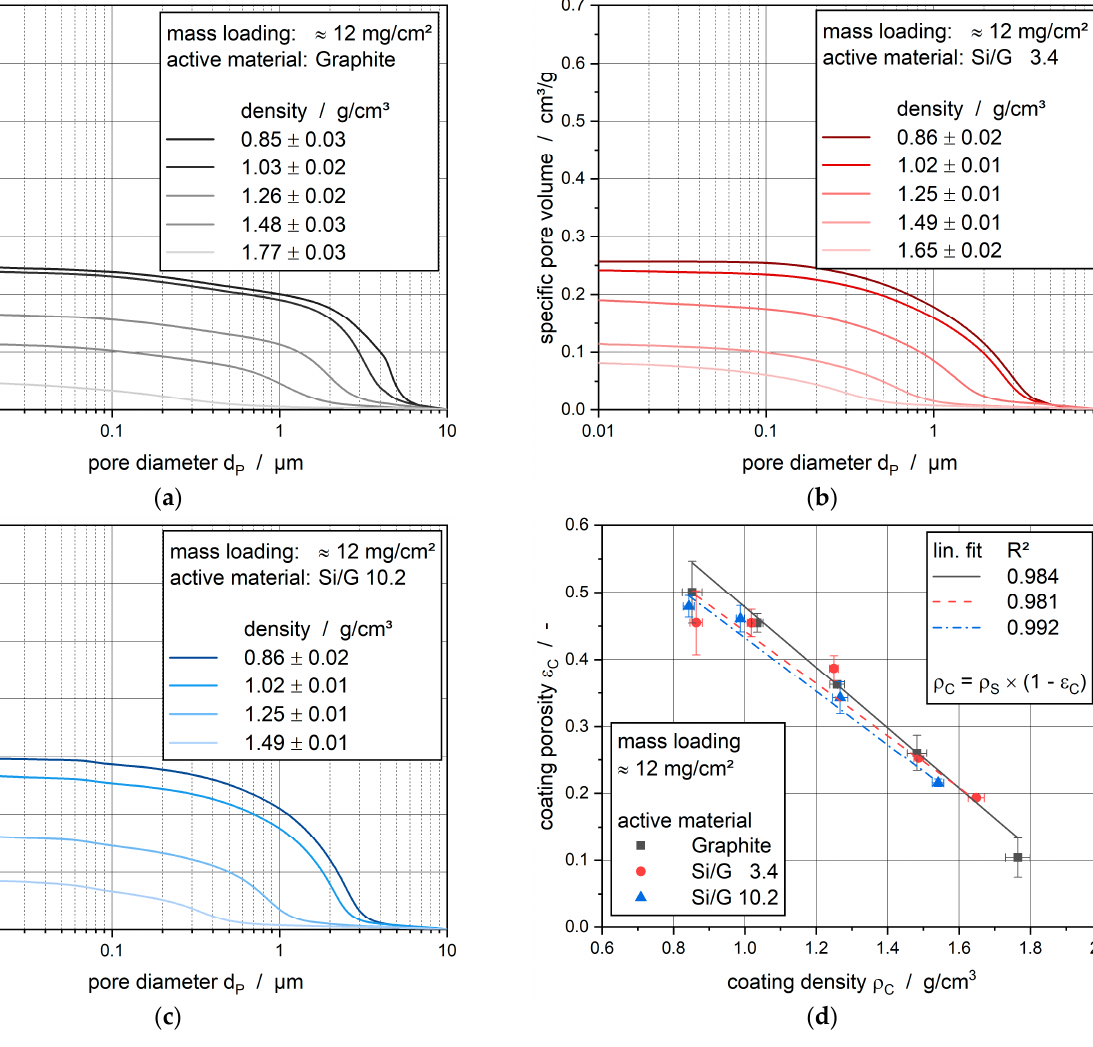
Figure 2. Specific pore volume of the ( a ) graphite electrode; ( b ) Si/G 3.4 electrode; ( c ) Si/G 10.2 electrode; ( d ) calculated coating porosity.